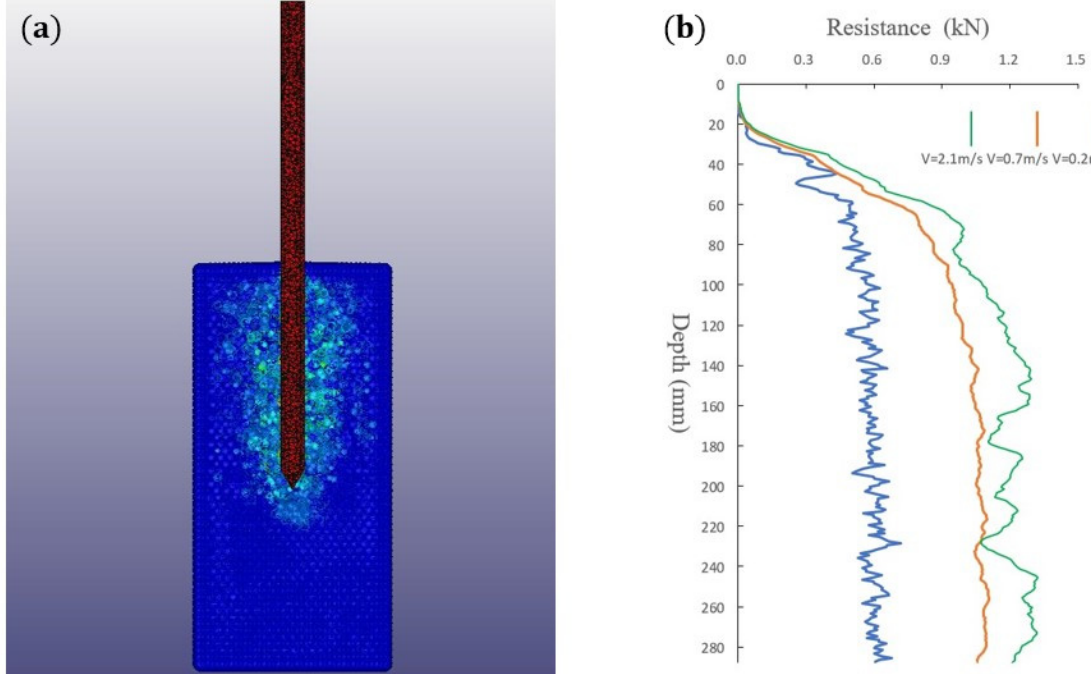
Figure 8. CPT test results: ( a ) distribution of soil displacement, ( b ) development of penetration resistance at different velocity.